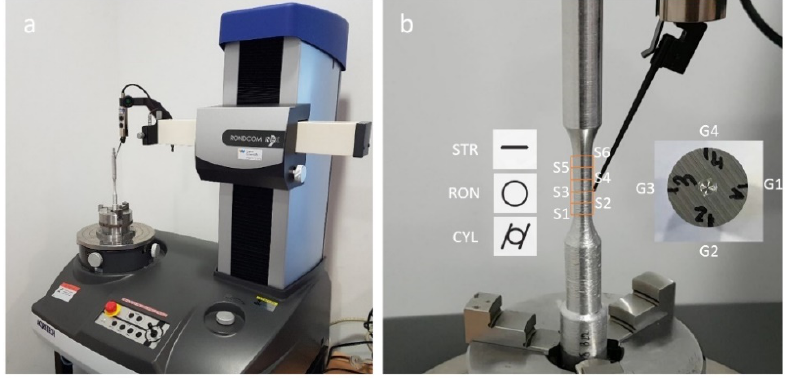
Figure 5. ( a ) Form-measuring machine; ( b ) form deviations measurement in the calibrated area.